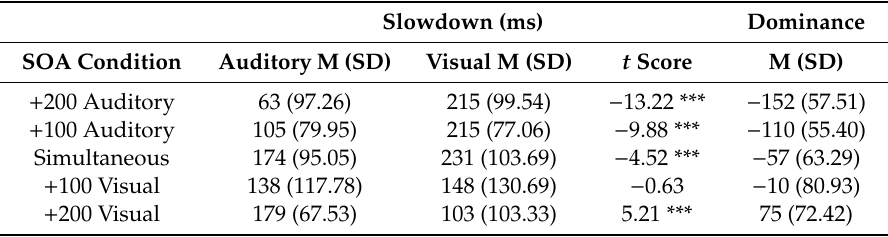
Table 3. Auditory dominance in the 1-button task. Means and standard deviations, and t statistics from pairwise comparisons of slowdown scores for auditory and visual oddballs. Means and standard deviations of visual dominance scores; negative values indicate auditory dominance and positive values indicate visual